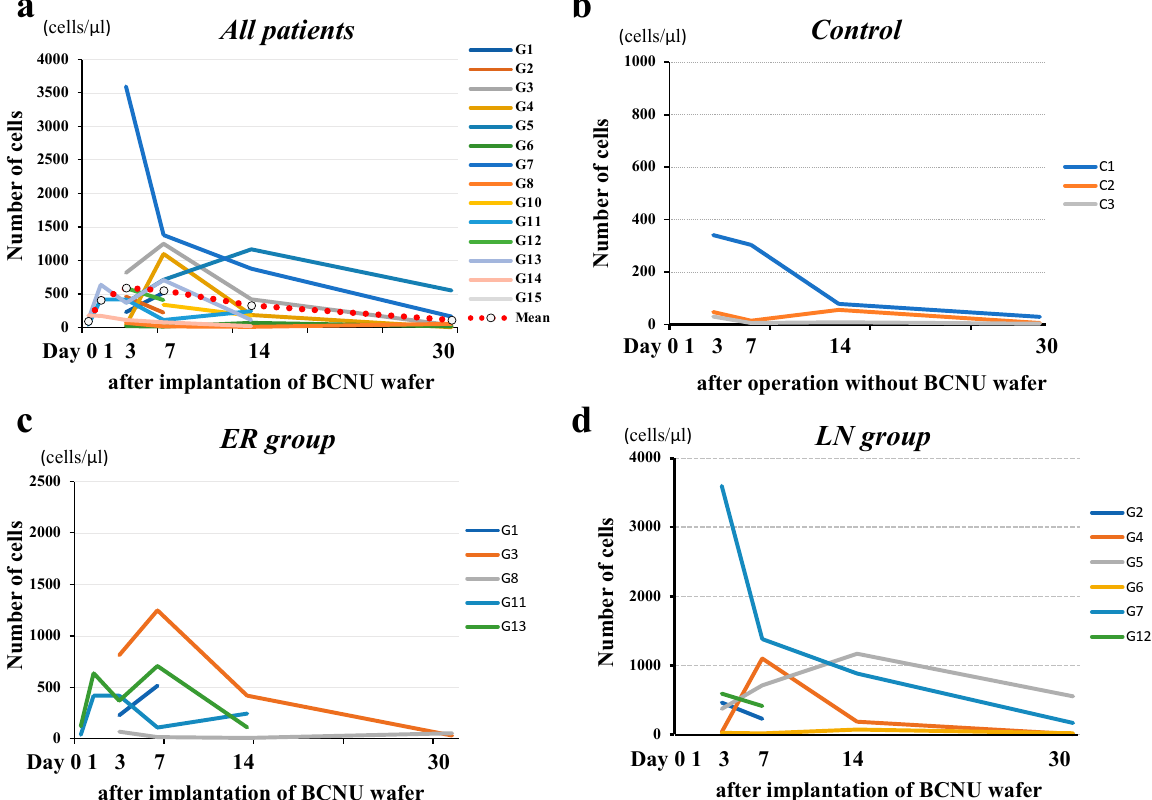
Figure 7. Time course of the number of cells in the resection cavity. ( a ) The number of cells in the resection cavity reached a maximum on the third postoperative day and gradually decreased